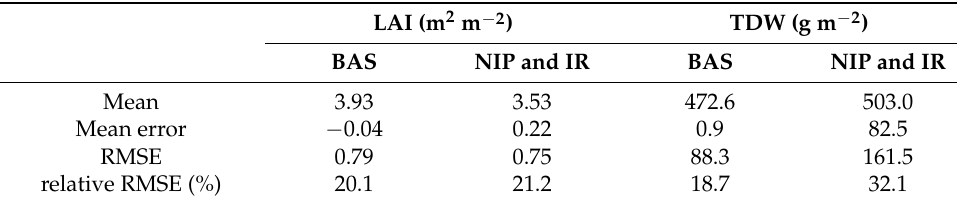
Table 3. Estimation accuracy of LAI and TDW for three rice cultivars in 2019 (Rep. 1, 2 and 3).